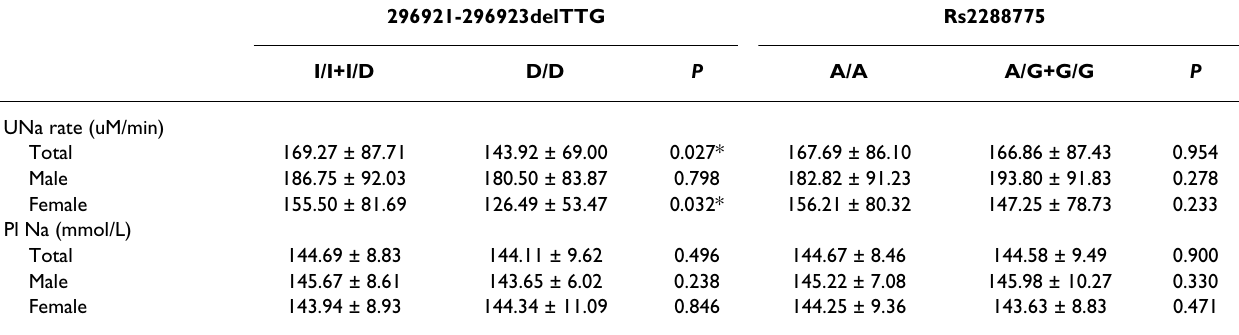
Table 6: Comparing of urinary Na excretion rate and plasma Na between different genotypes by Covariate variance analysis adjusting for age, smoking, and